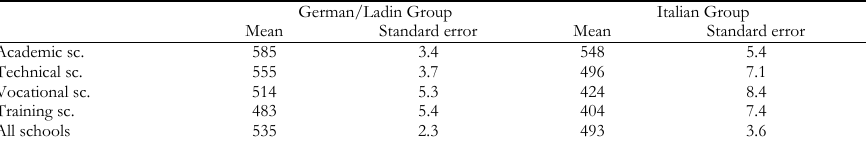
Mean score in science - PISA 2006,